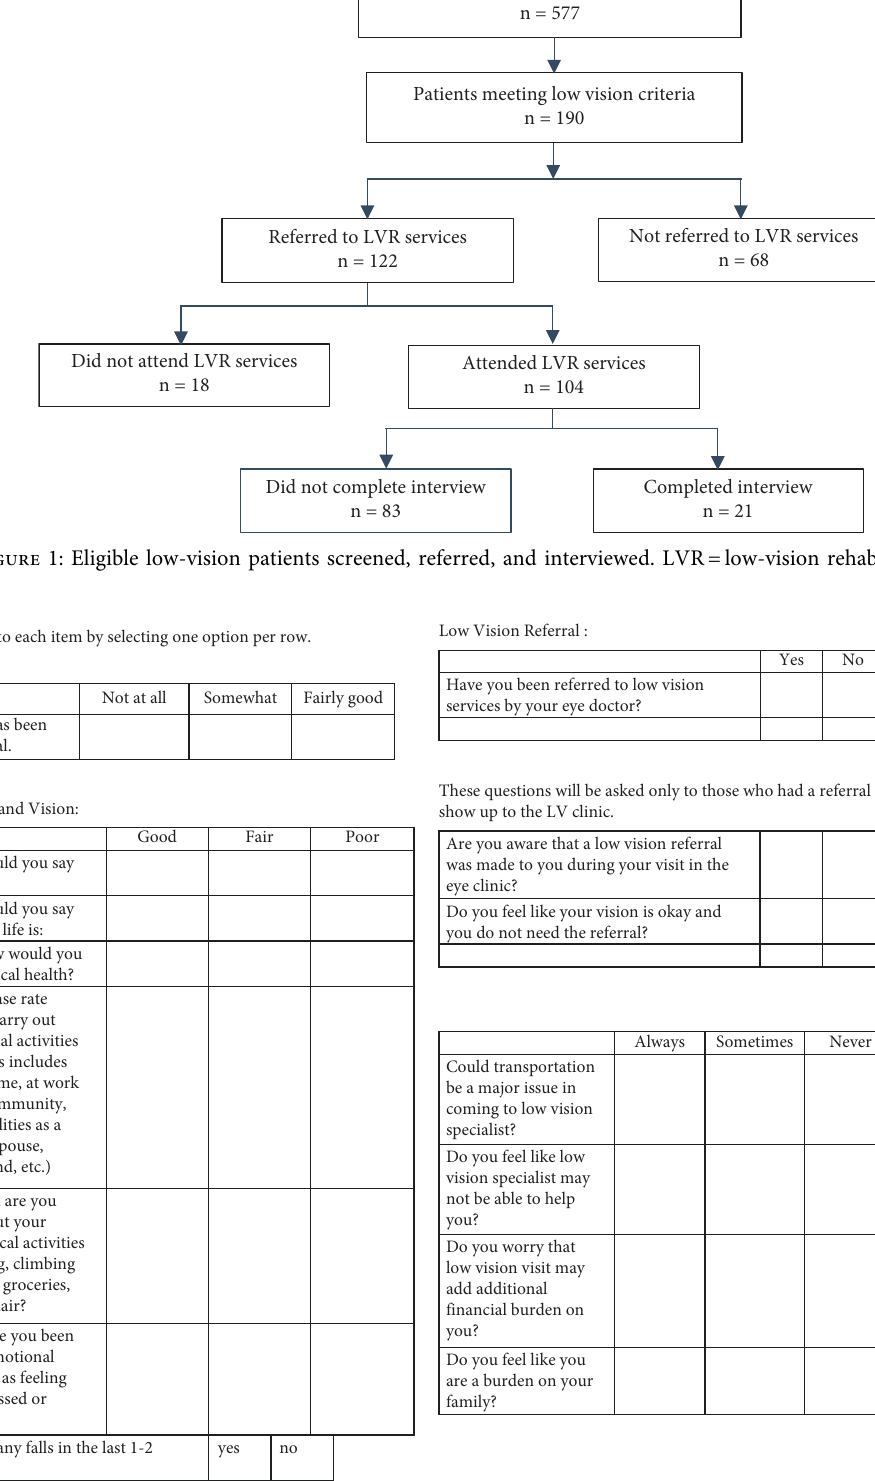
Figure 2: Low-vision patient questionnaire. Patients provided responses during phone interviews with members of the research